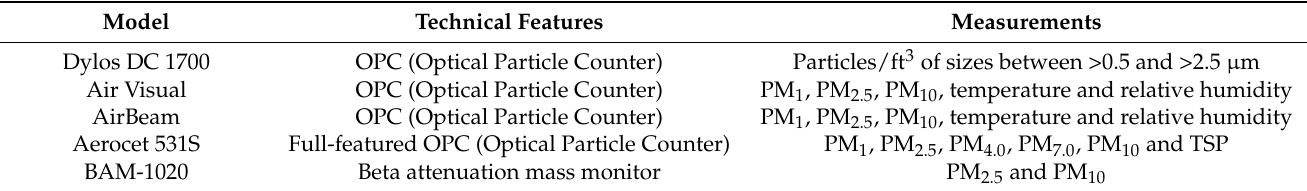
Table 1. Details of the OPC analyzers used and the reference tool,